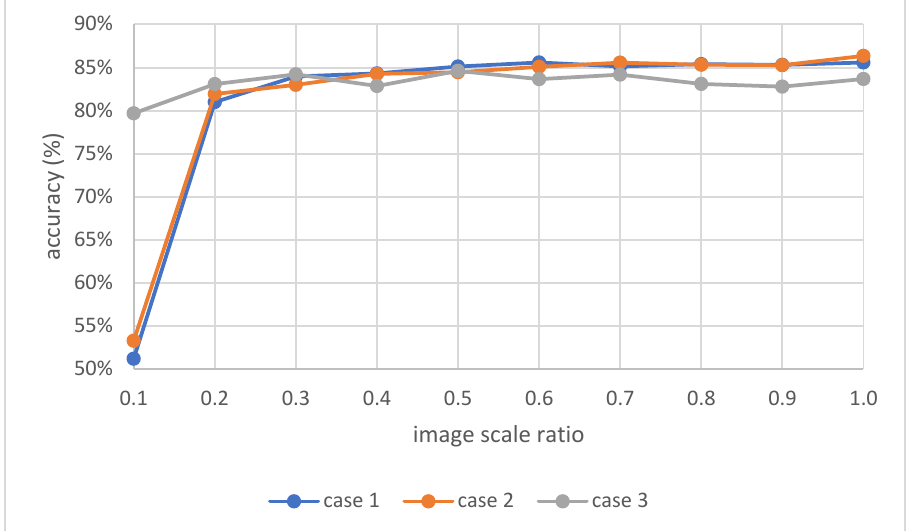
Figure 8. F-measure accuracy of change detection according to the image size and image pixel value range. Case 1—original image, case 2—image minus 127.5, case 3—image minus average pixel value.